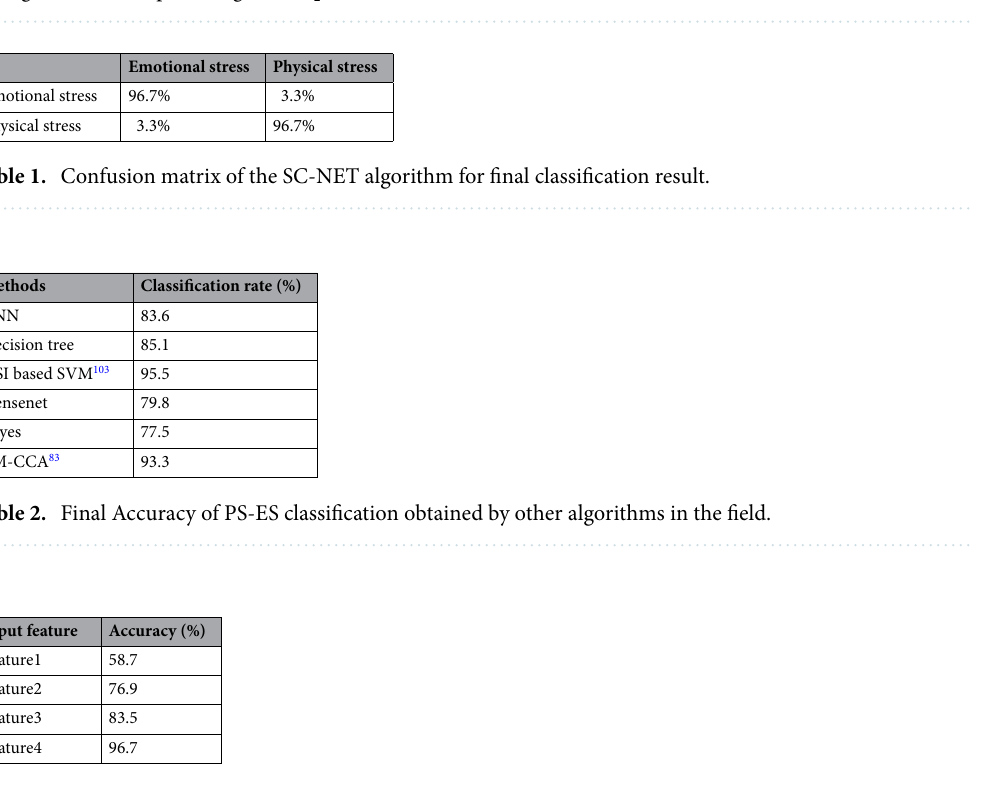
Figure 9. ROI experimental data example. ( a ) Illustration of the experimental setup of the imaging system and the spectral reflectance of relevant pixels. ( b ) StO 2 signal sample of ROI. As shown in the ( b ), the color bar on the right reflects the percentage of StO 2 .